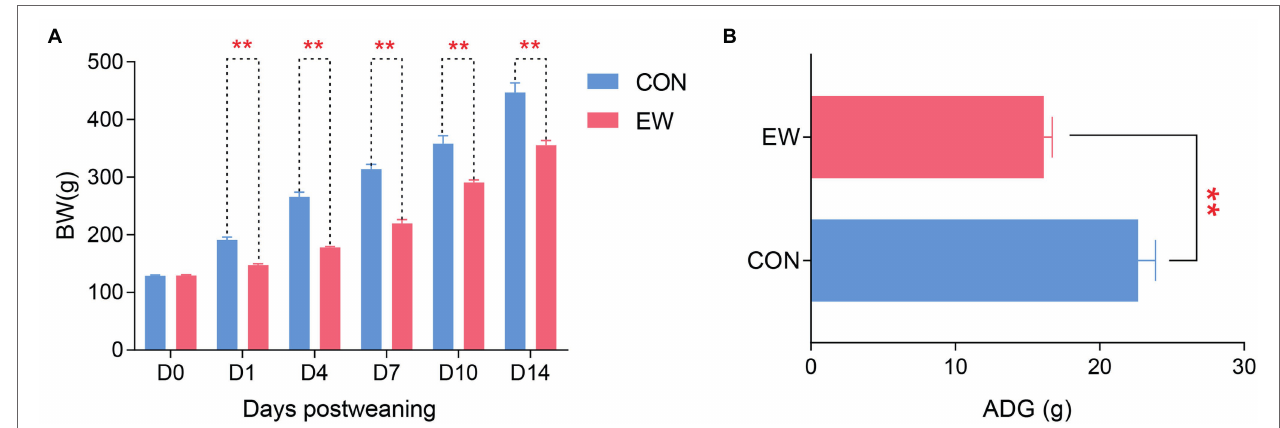
FIGURE 1 | Effects of early weaning on BW (A) and ADG (B) of squabs. D1, D4, D7, D10, and D14 means 1, 4, 7, 10, and 14 days postweaning, respectively. Values are means with their standard errors of eight squabs. ** mean p < 0.01, within each time points postweaning. BW, body weight; ADG, average daily gain; CON, control group; EW, early weaning